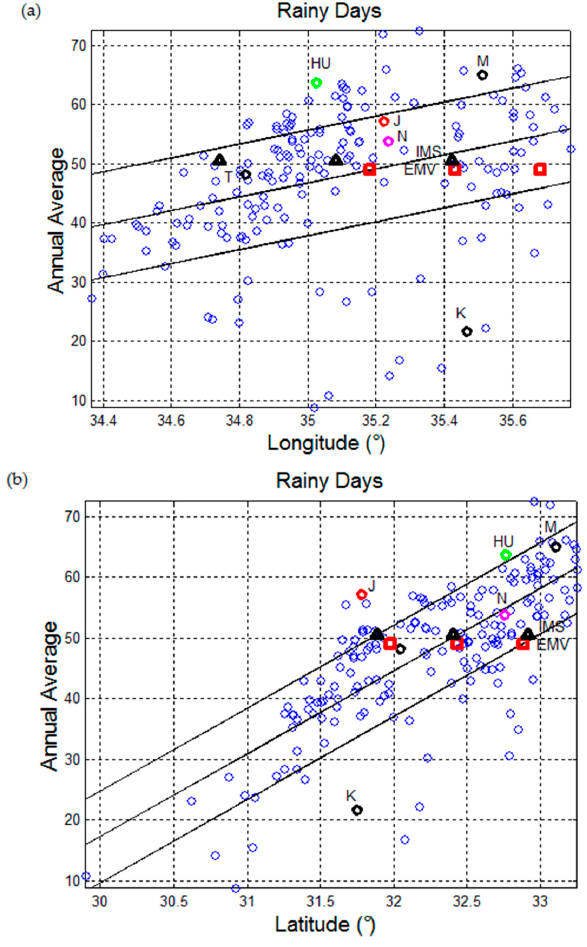
Figure 3. Annual average value of rainy days for 184 localities of the Holy Land versus longitude (a) and latitude (b) from 1990 to 2015, according to the IMS. Triangles refer to the average value versus the average longitude or latitude and ± 1 standard deviation of these parameters. Squares refer to the value obtained from the EMV (49) for the average longitude or latitude and ± 1 standard deviation of these parameters for the 159 localities with latitude > 31.5 ◦ (minimum latitude of the localities of Table 3). Explicitly indicated are the values of Jerusalem (J), Tel Aviv (T), Haifa University (HU), Nazareth (N), Malkiya (M), Kalya